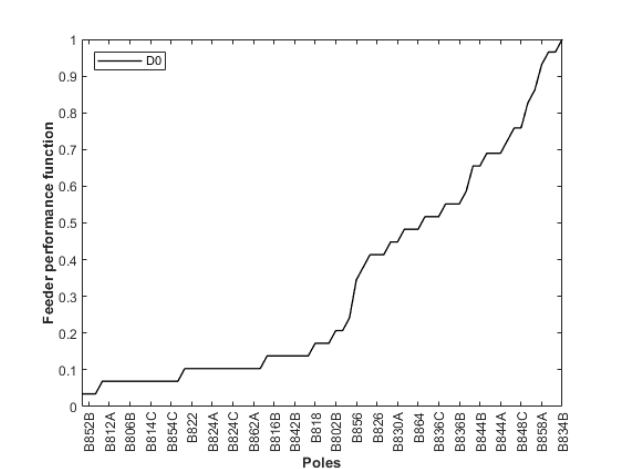
Figure 12. D function for the base case with m = 0 and n = 1. Labels A, B, and C refer respectively to Phases A, B and C.